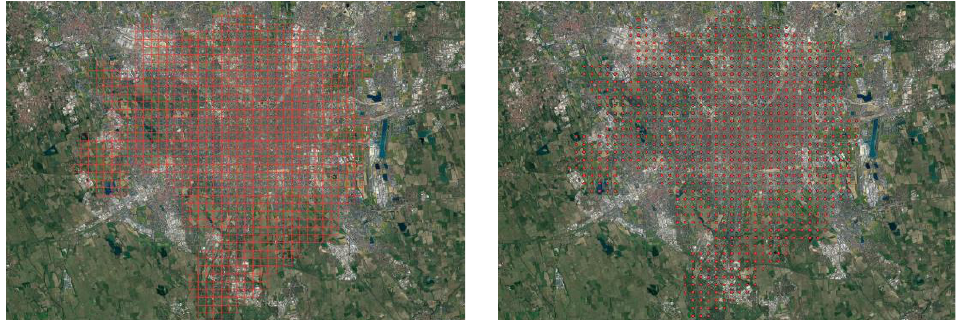
Figure 6. Left picture: the considered 500 m × 500 m grid overlapped on the Google satellite image map; right picture: centroids of each square.